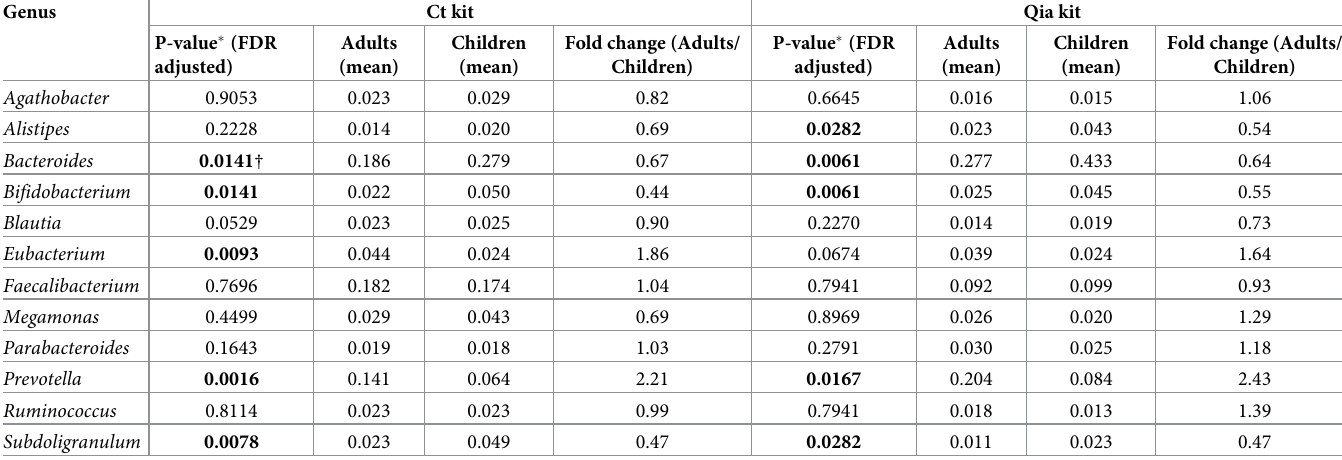
Table 2. List of taxa showing different abundance between adults and children at the genus level.